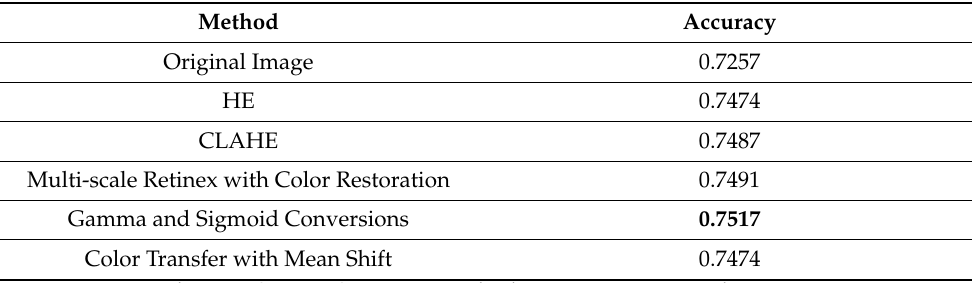
Table 6. Accuracy of 3 color transfer methods in 3 polyp classes.